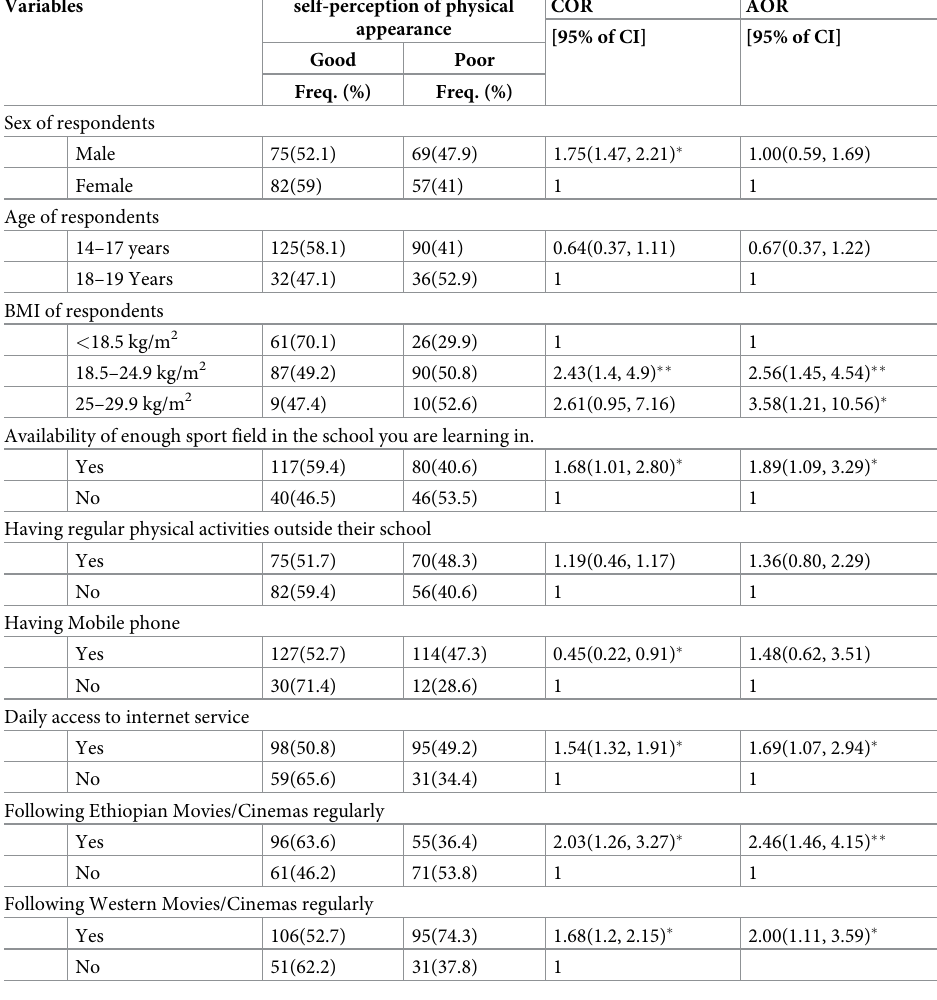
Table 6. Factors associated with self-perception of one’s physical appearance of adolescents in, Addis Ababa city, Ethiopia.